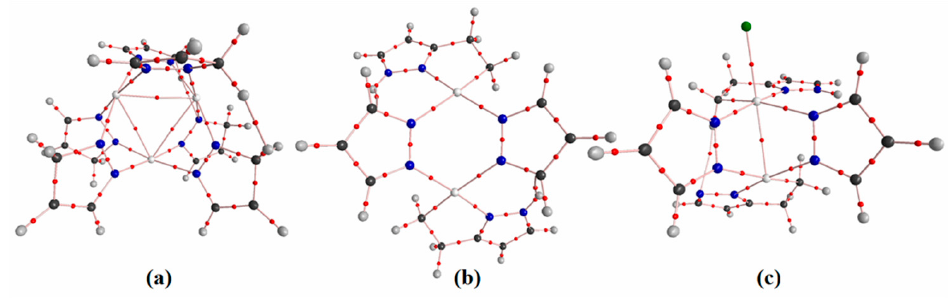
Figure 6. Molecular graphs of the simplified ( a ) 1 ( b ) 2 , and ( c ) 3 configurations. Ring and cage BCPs are omitted for clarity. The red spheres at the center of the interatomic bond lines denote the bond critical points (BCP).